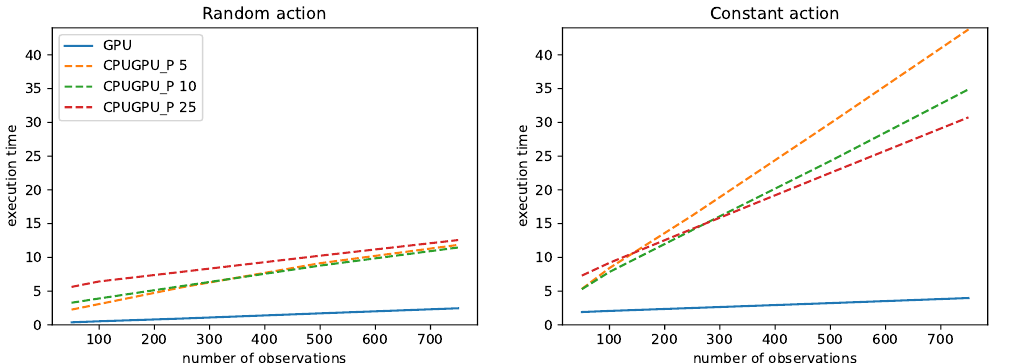
Figure 7. Comparison of execution time of the two best performing implementations with respect to the number of observations. Results for both scenarios with